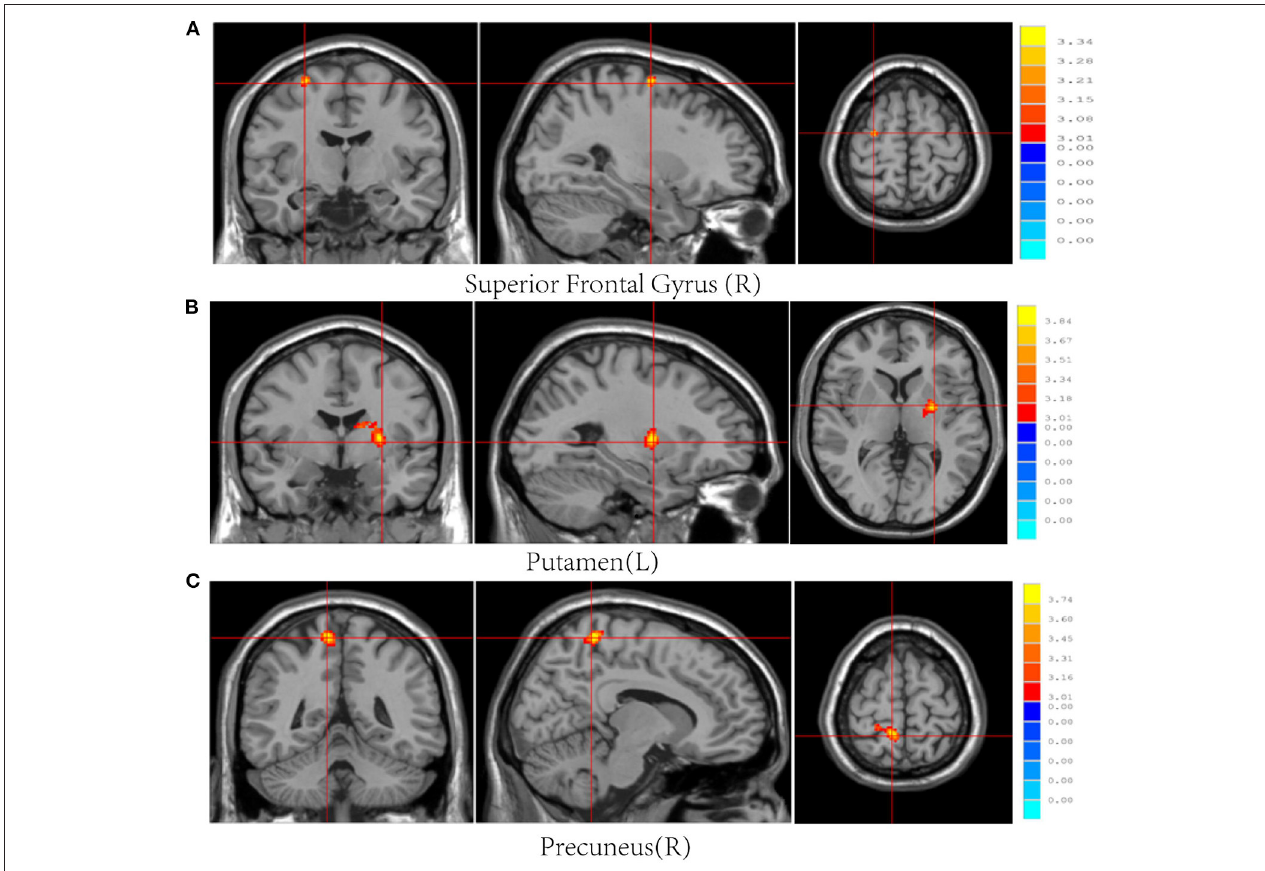
FIGURE 2 | Results of brain region changes in mTBI male patients compared with male controls. The CBF of male patients in right superior frontal gyrus (A) , left putamen (B) , and right precuneus (C) showed increased perfusion levels compared with male controls. mTBI, mild traumatic brain injury; CBF, cerebral blood